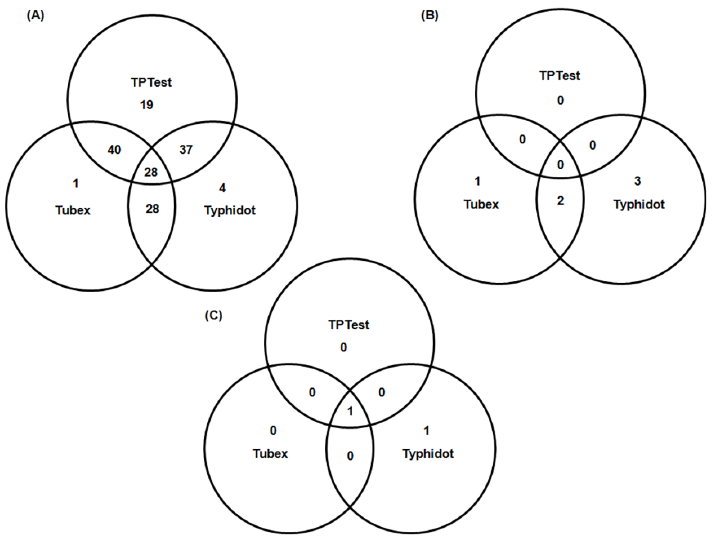
Fig 1. Venn diagram indicating (A) the patients in the six groups, (B) the healthy controls and (C) the patients with other febrile diseases are positive with each of the three tests (TPTest, Tubex and Typhidot).